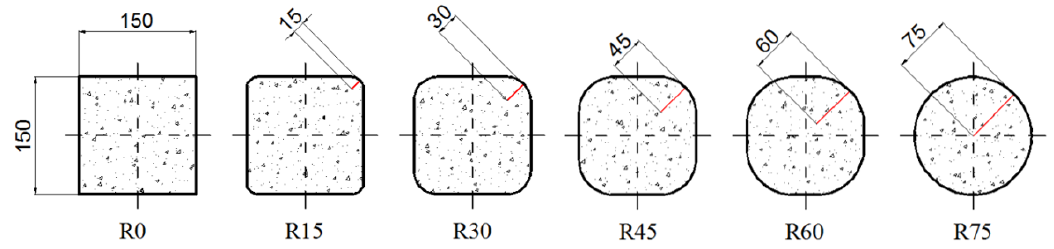
Figure 2. Cross-section corner radii of the columns.